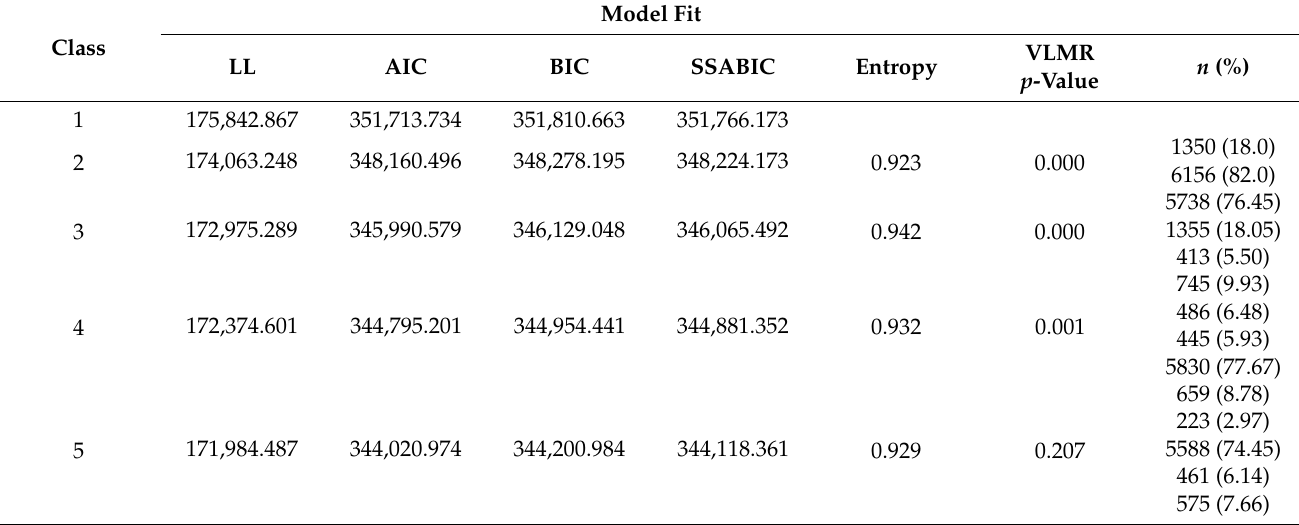
Table 3. Fitness of the models of change types in AUDIT